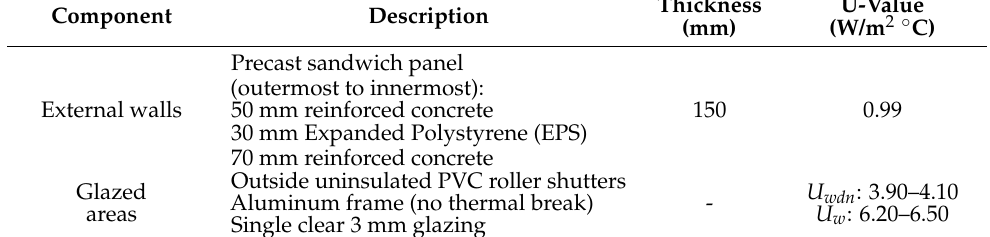
Table 2. Envelope vertical components: physical and thermal characteristics.